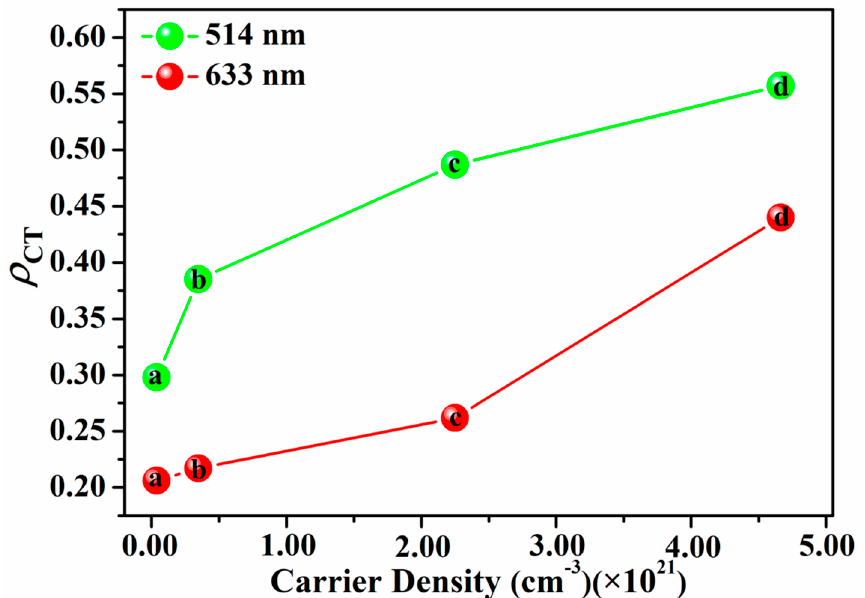
Figure 5. Relationship between the degree of CT ( ρ CT ) and the carrier density for different Ag sputtering powers (from 10 to 40 W) under 514 (green) and 633 nm (red) laser excitations, where “ a ”, “ b ”, “ c ”, and “ d ” represent Ag-10 W/ZnO-100 W, Ag-20 W/ZnO-100 W, Ag-30 W/ZnO-100 W, and Ag-40 W/ZnO-100 W, respectively.